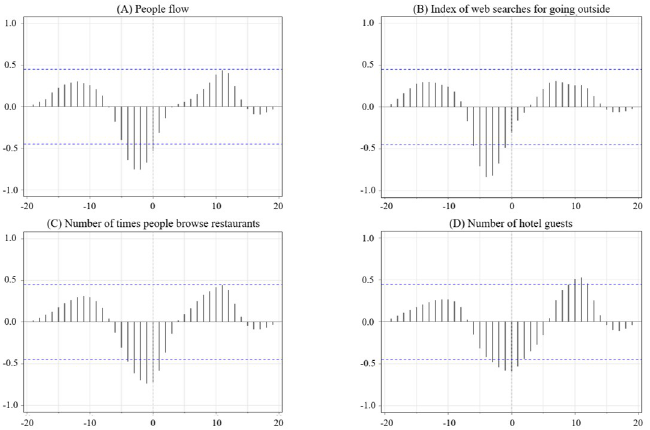
Fig 2. Cross-correlation of new PCR positive cases with A) people flow, B) the index of web searches for going outside, C) the number of times people browse restaurants, and D) the number of hotel guests in the first wave. The y-axis indicates the correlation coefficient and the x-axis indicates the lag. Dashed blue lines indicate 95% confidence intervals for a null model of no association.